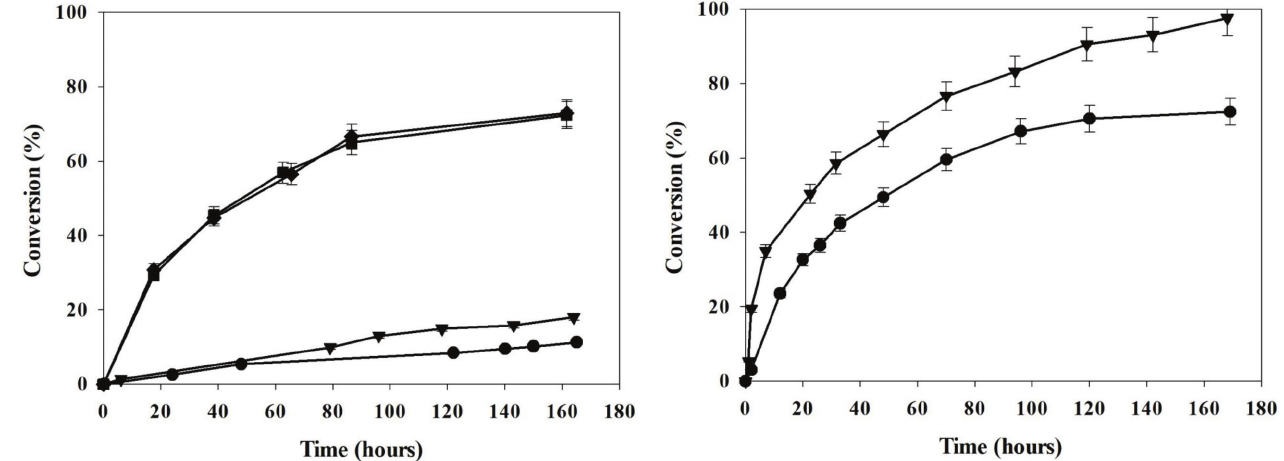
Fig. 4 – Conversion variation with time in the synthesis of PGPR in two different reactors, an open air and a vacuum reactor. Reaction conditions: 30 g ricinoleic acid, 2.5 g poly - glycerol-3, 3.6 g immobilized derivative, 70 °C, 350 rpm.